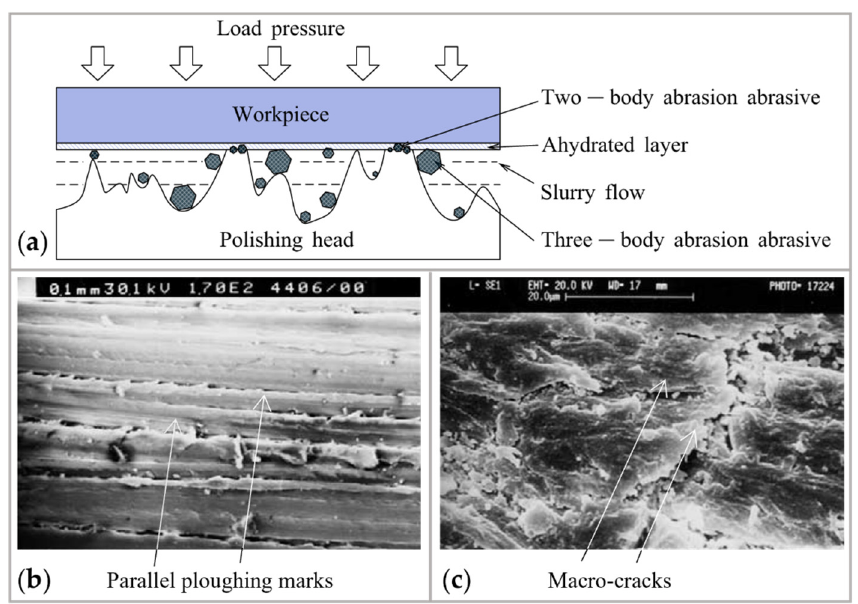
Figure 7. The contact model of the workpiece and polishing pad: ( a ) The schematic of CMP in micro view; ( b ) Scanning electron microscope (SEM) images of polyetherketone, under two-body abrasive abrasion, and ( c ) Three-body abrasive abrasion. Reproduced with permission from [77].